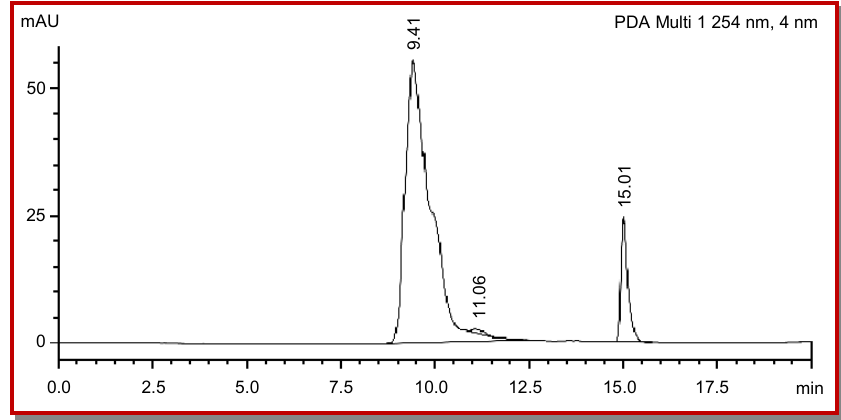
Figure 4: Chromatogram of ethyl acetate fraction of stem presenting gallic acid peak